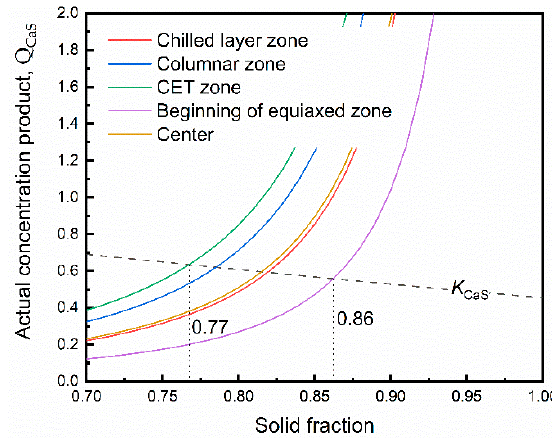
Figure 12. Formation of CaS in different zone.